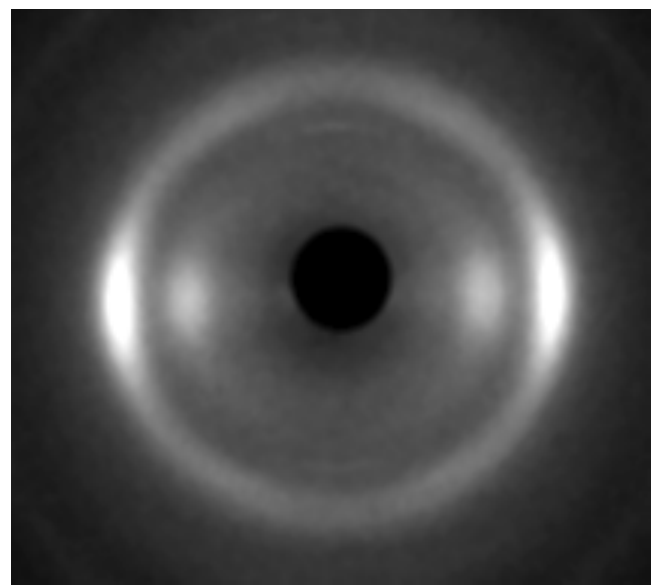
Figure 11. X-ray diffraction pattern of wood with fiber direction approximately vertical. Figure 11. X-ray di ff raction pattern of wood with fiber direction approximately